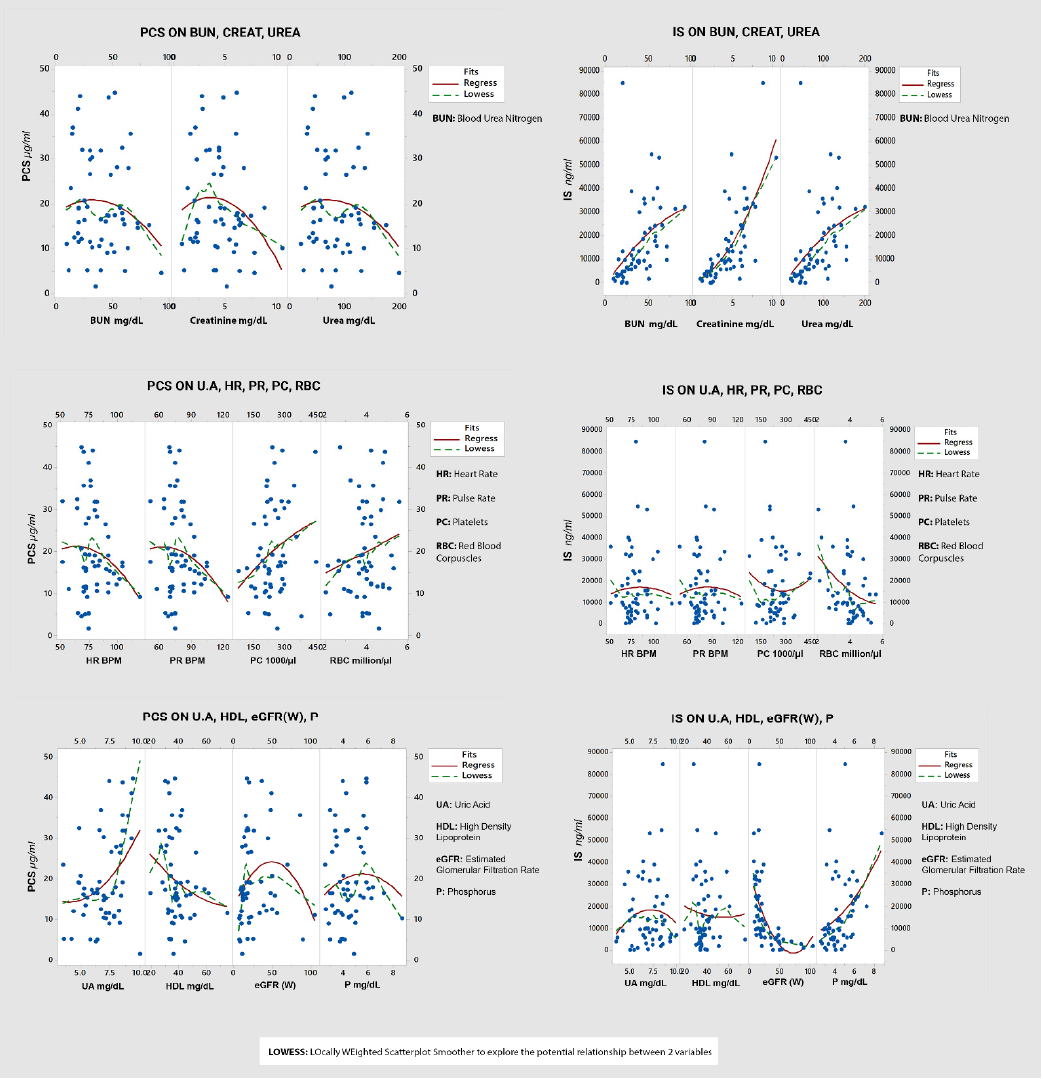
Figure 4. Matrix plots showing the relationship of PCS and IS with uremic parameters. BUN, blood urea nitrogen; CREAT, creatinine; UREA, urea; HR, heart rate; PR, pulse rate; PC, platelet count; RBC, red blood cells; UA, uric acid; HDL, high-density lipoproteins; eGFR(W), estimated glomerular filtration rate (Cockcroft–Gault method). The association of PBUTs with each routine parameter was examined, and the sig- nificance of the association is given in Table 6 for PCS and IS. Table 6 The correlation of PCS and IS with uremic parameters.